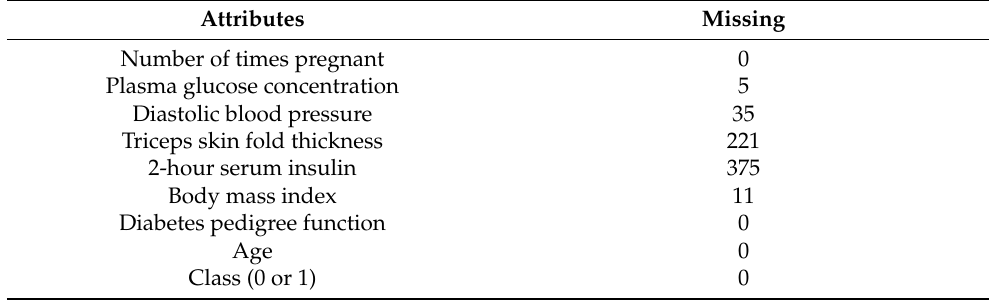
Table 1. PID dataset configuration.